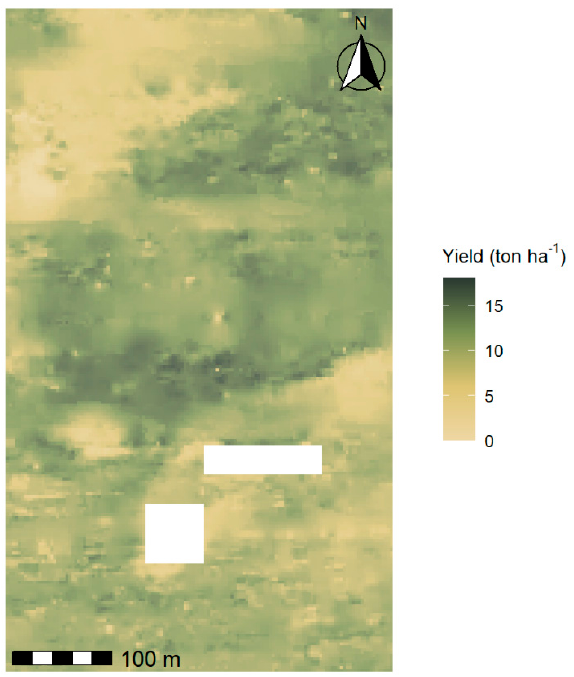
Figure 4. A yield map derived by a weighing harvesting machine on August 22, 2016.